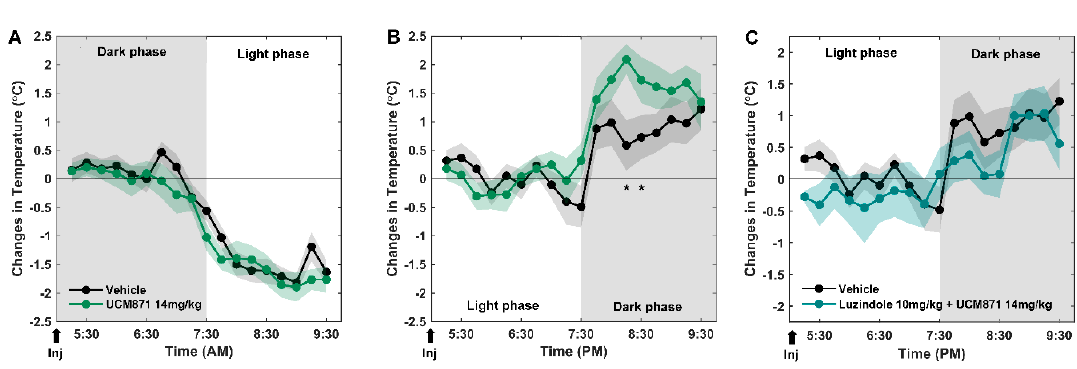
Figure 4. Changes in T b after UCM871 (14 mg/kg, s.c.) treatment during the light and the dark phase. ( A ) UCM871 administered at 5:00 a.m. (dark phase) does not produce any change in the T b compared with vehicle. ( B ) UCM871 administered at 5:00 p.m. (light phase) increases T b after the light–dark transition compared with vehicle. ( C ) Luzindole pre-treatment blocks the e ff ect of UCM871 on T b . Data are expressed as mean ± SEM (graded shades). Lights on at 7:30 a.m. and o ff at 7:30 p.m. * p < 0.05 versus vehicle; two-way ANOVA for repeated measures followed by Bonferroni post hoc test. Inj: s.c. injection of either vehicle, UCM871, or UCM871 +